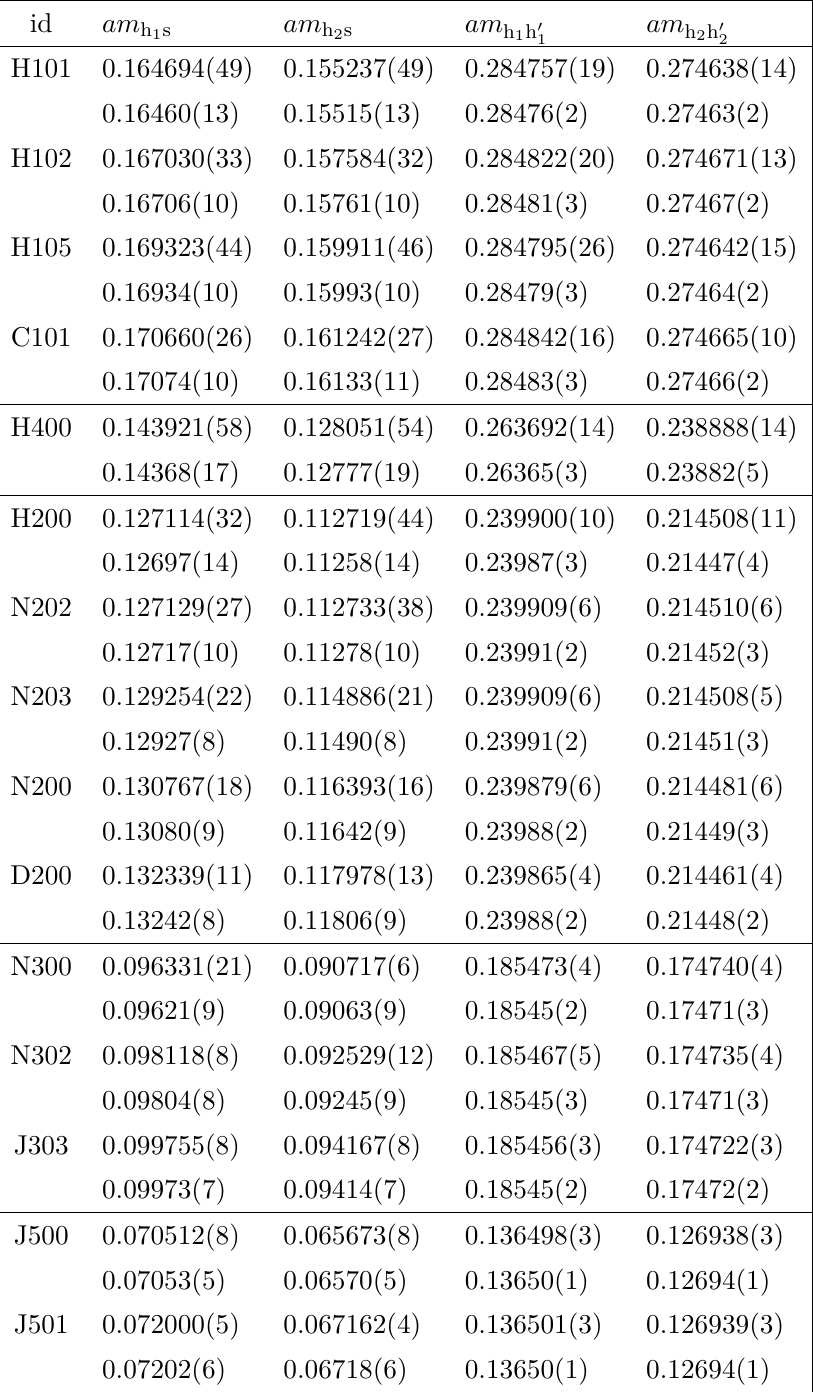
Table 9 . Overview of the results for heavy-strange and heavy-heavy PCAC quark masses from improved lattice derivatives, referring to the heavy quark hopping parameter choices given in table 2. As before, for every ensemble we list the numbers before the shift in the rows with labels and the corresponding ones after the shift to φ phys in the rows without labels. Analogous results from 4 standard lattice derivatives are collected in table